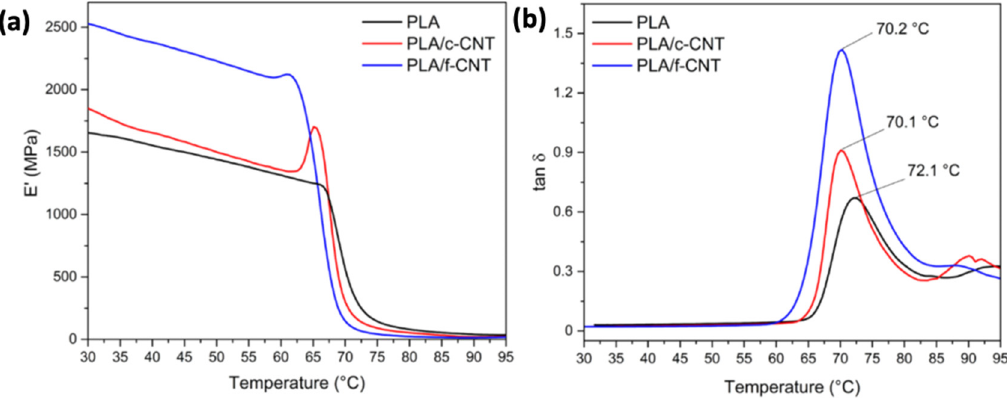
Figure 20. ( a ) Storage modulus (E ′ ) and ( b ) Tan δ of pure PLA, PLA/c-CNT, and PLA/f-CNT obtained from DMA [238].